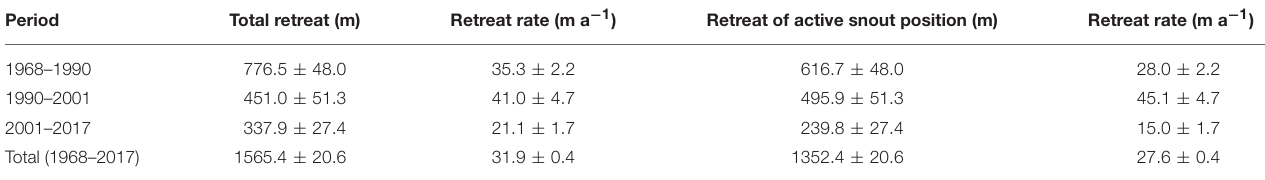
TABLE 2 | Length changes of the Milam glacier between 1968 and